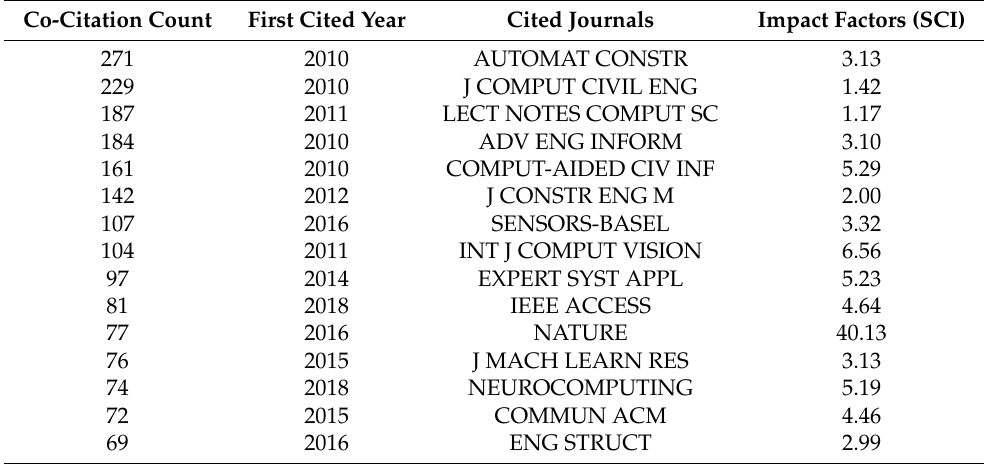
Table 3. Cited journal frequencies (Impact Factors (IFs) are based on the first cited year). Co-Citation